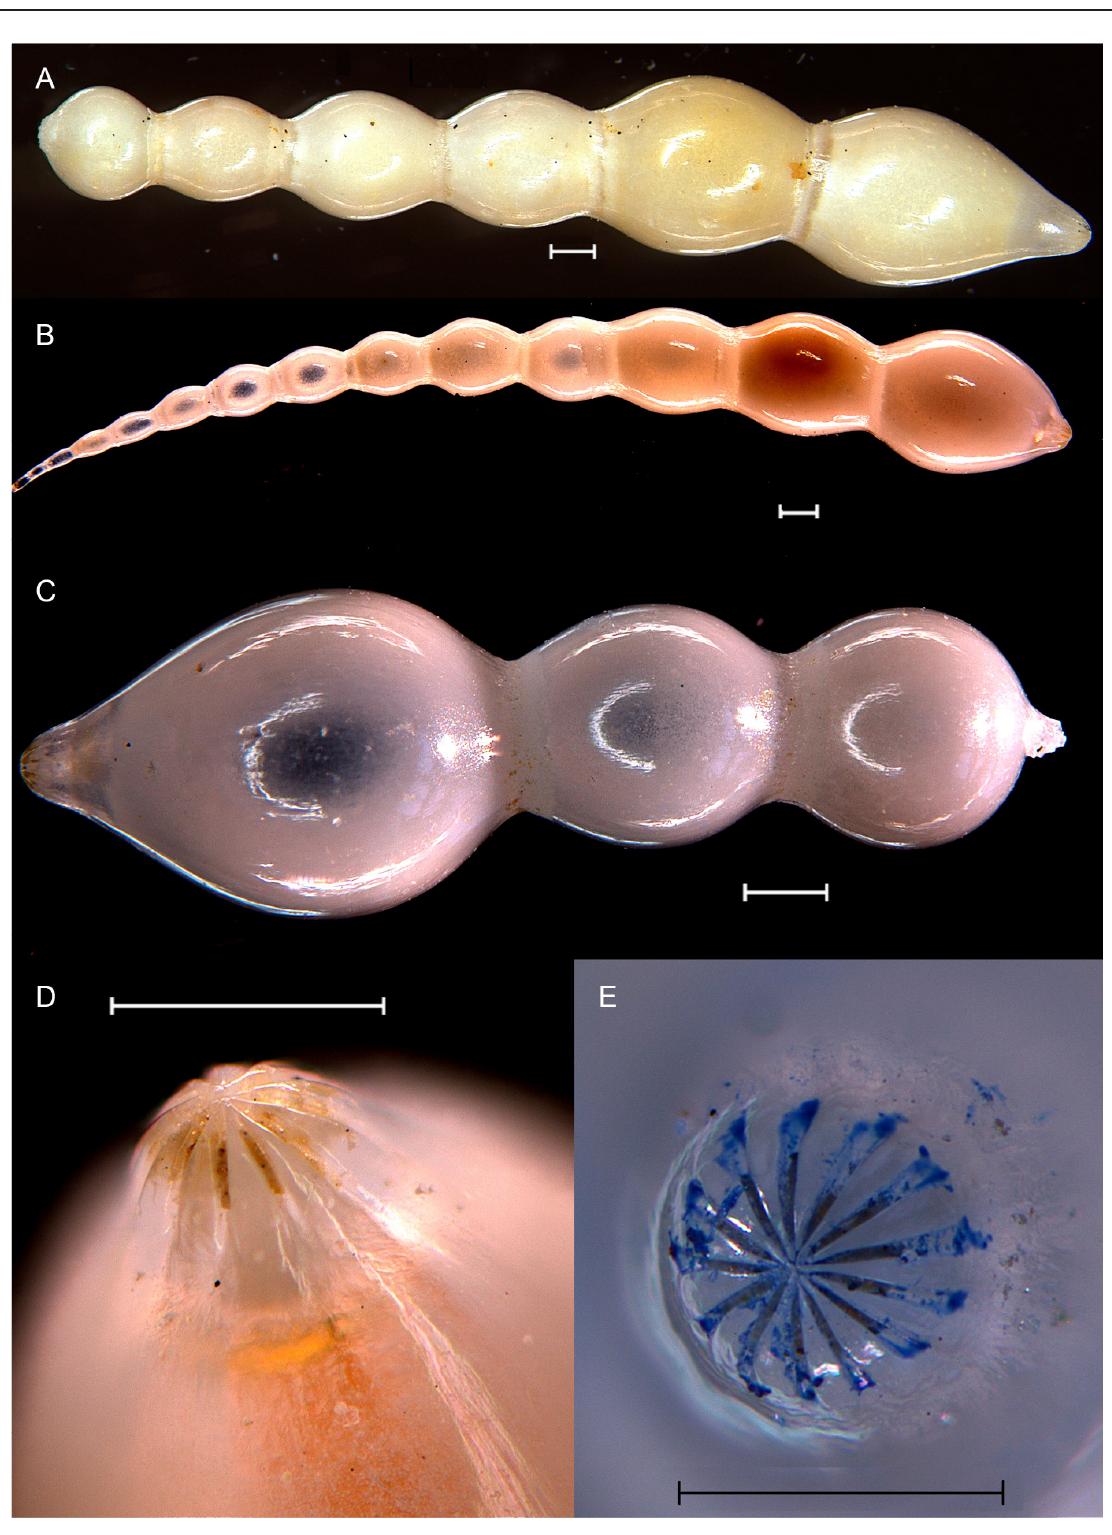
Fig. 12. Nodosaria subsoluta Cushman, 1923. A . Megalosphere side view (BIOICE 2868, IINH 40218). B, D . Microsphere (BIOICE 2219, IINH 40182), side view of specimen containing cytoplasm (B) and aperture (D). C, E . Megalosphere (BIOICE 2978, IINH 40347), side view (C) and aperture (E) stained with indigo blue. Light source combination of incident light and dark field. Scale bars = 0.25